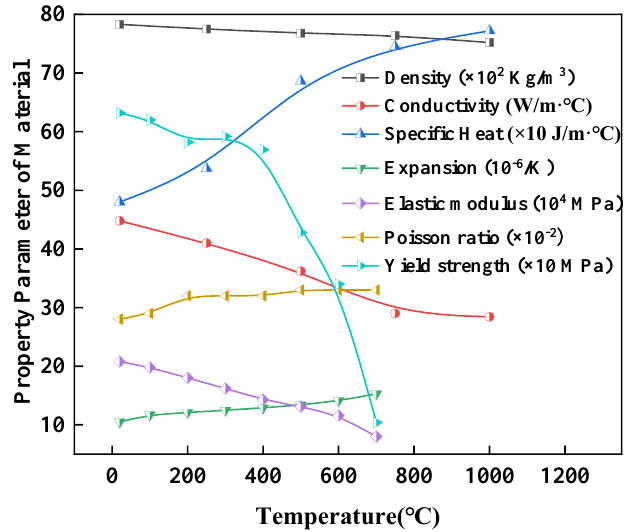
Figure 7. Temperature dependent material properties.